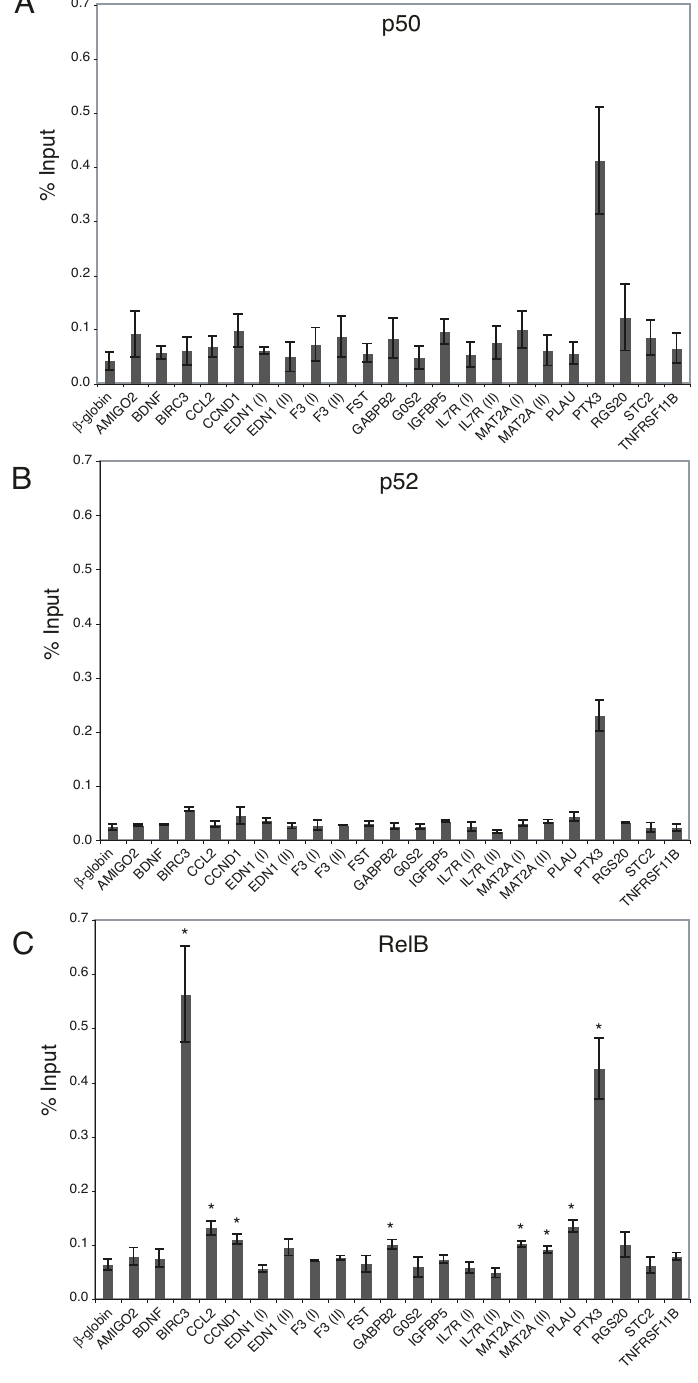
Figure 6 Analysis of NF B binding sites in proliferating cells by chromatin immunoprecipitation . Chromatin fragments from proliferating T98G cells were immunoprecipitated with either anti-p50 ( A ), anti-p52 ( B ), or anti-RelB ( C ) antibody and quantified by real-time PCR. Data are presented as the percentage of input and are the means of 2 independent experiments with anti-p50 and anti-p52 or 3 independent experiments with anti-RelB ± S.E. - globin was used as the negative control. In panel C , (*) represents statistically significant binding compared to -globin (assessed by t